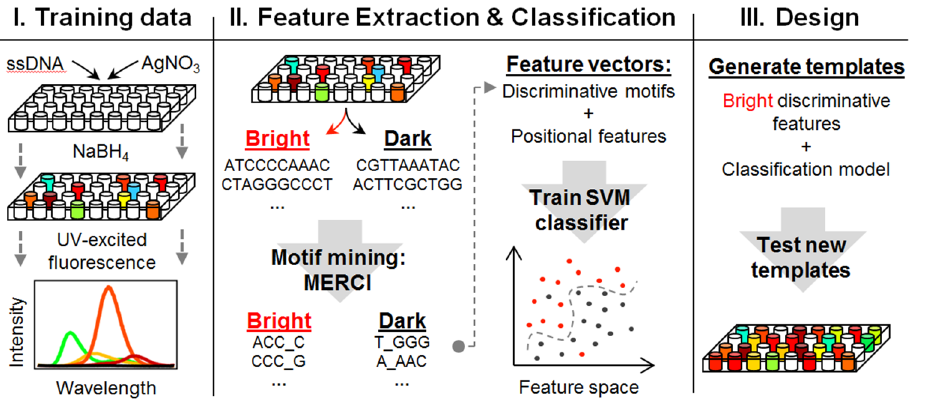
Figure 8. Methods used to establish that multi-base motifs are key to formation of fluorescent Ag N -DNA, to recognize discriminative base motifs within DNA templates and to construct new templates for solutions with increased brightness. (Adapted with permission from reference [70]). ( a ) Robotic synthesis on nearly 700 randomly generated 10-base DNA templates, and fluorescence measurement one week later, created a large, unbiased data set without unstable fluorescent products; ( b ) By running support vector machine (SVM) classifiers with different choices of feature vector, we established that multibase motifs are key to formation of fluorescent Ag N -DNA. A motif-miner algorithm, MERCI, was optimized to identify these discriminative motifs; ( c ) Combining the discovery of certain multi-base motifs important for determining fluorescence brightness with a simple generative algorithm, the probability of selecting DNA templates that stabilize fluorescent silver clusters was increased by a factor of >3 relative to random